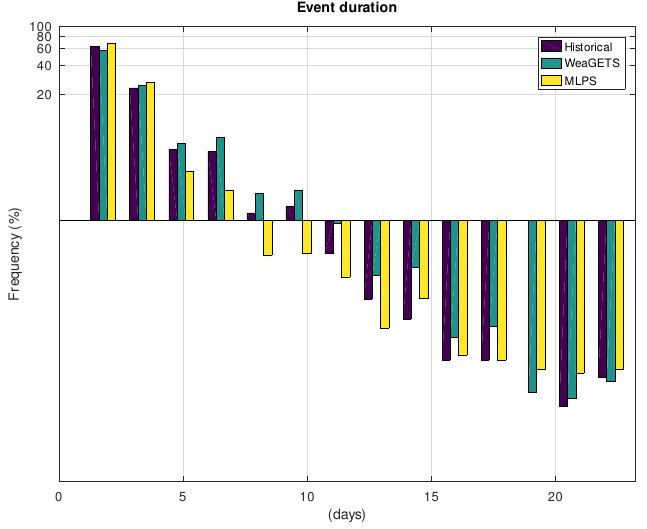
Figure 6. Histogram of the event duration of daily synthetic time series (WeaGETS and MLPS) and historical values of the Hohenpeissenberg weather station.